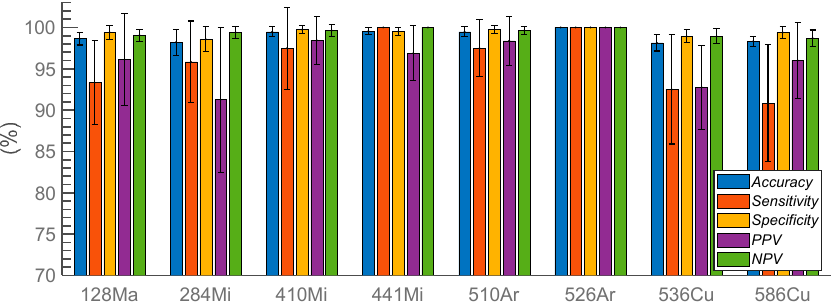
Figure 5. Classification performance of eight bacterial species utilizing the elastic net logistic regression classifier created with hyperspectral ELS data (n = 10). Table 1. A comparison of three different classification methods by PPVs: individual classifications with a linear SVM for every wavelength, a linear SVM with all features from entire wavelengths, and the elastic net logistic regression model (n = 10).